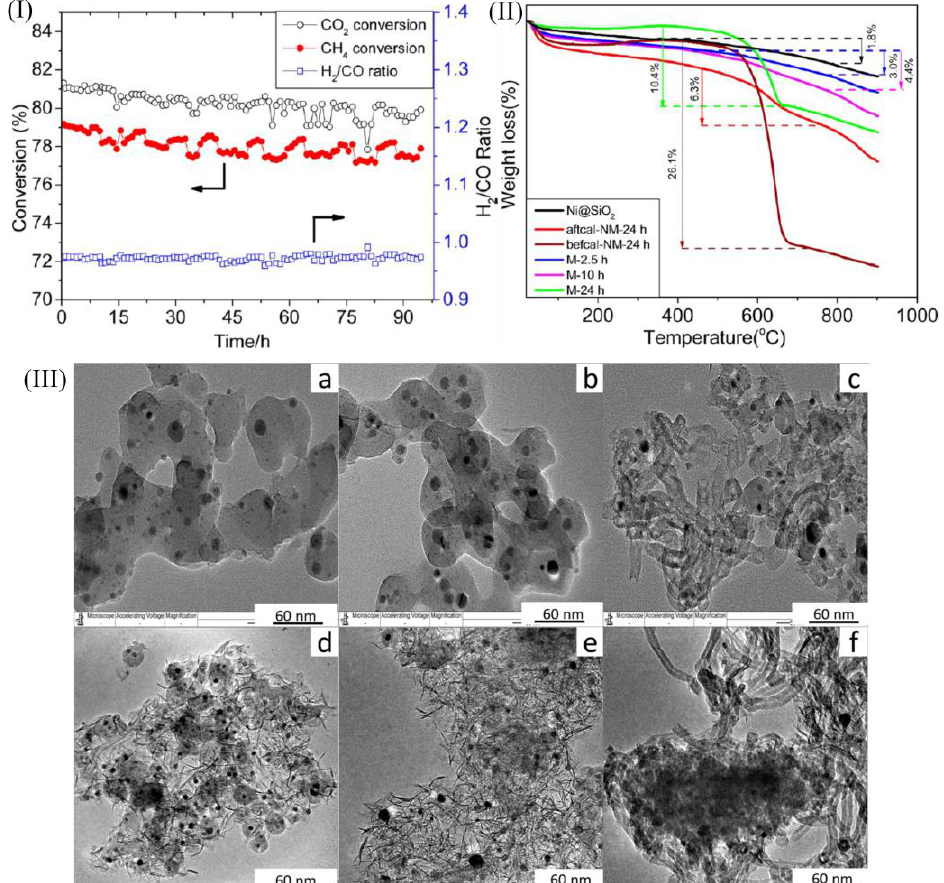
Figure 10. ( I ) Stability of the catalyst treated for 10 h and calcined at 700 °C. ( II ) Thermogravimetric analysis (TGA) for the utilized catalysts with various structures. ( III ) TEM images of the utilized catalysts after 20 h of reaction ( a ) Ni@SiO 2 , ( b ) aftcal-NM-24 h, ( c ) befcal-NM-24 h, ( d ) M-2.5 h, ( e ) M-10 h, and ( f ) M-24 h. Reprinted with permission from [75]. Copyright (2014), with permission from the American Chemical Society.